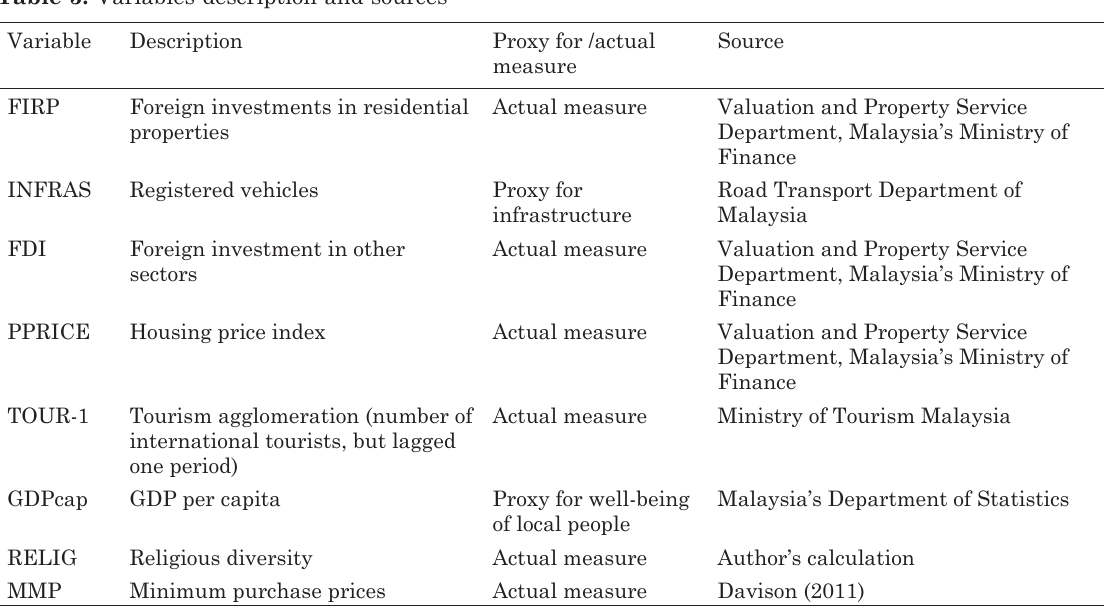
Table 3. Variables-description and